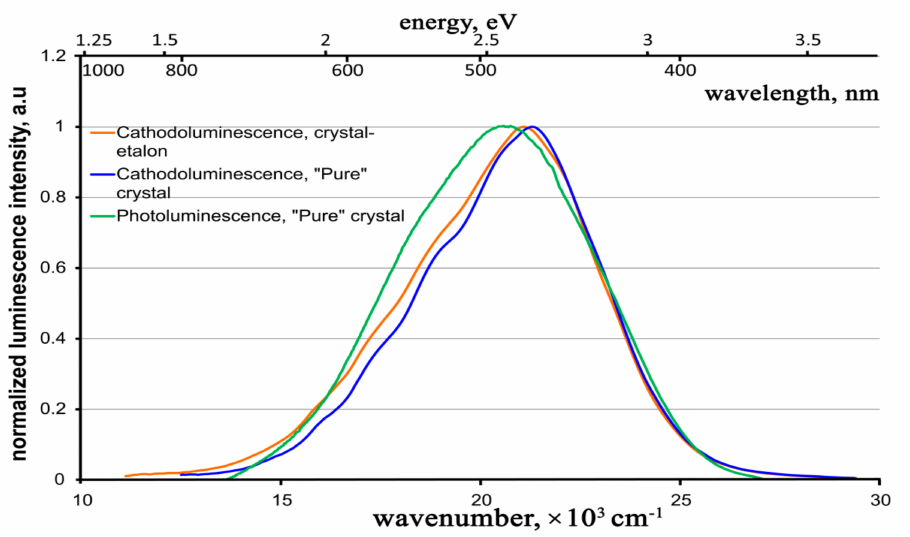
Figure 11. Normalized cathodoluminescence spectra for both the crystals under study and photolu- minescence spectrum for the “pure” crystal.